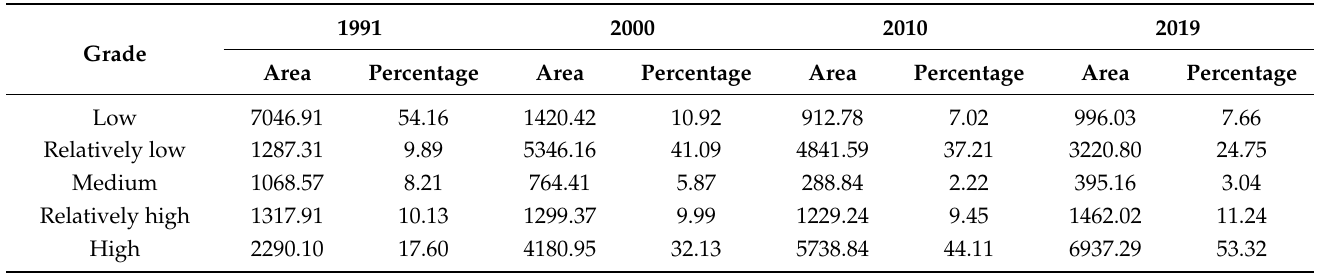
Figure 8. Spatial variation in habitat quality along the Yellow River section of the Hobq Desert from 1991 to 2019. Table 6. Proportion of each habitat quality level along the Yellow River section of Hobq from 1991 to 2019.